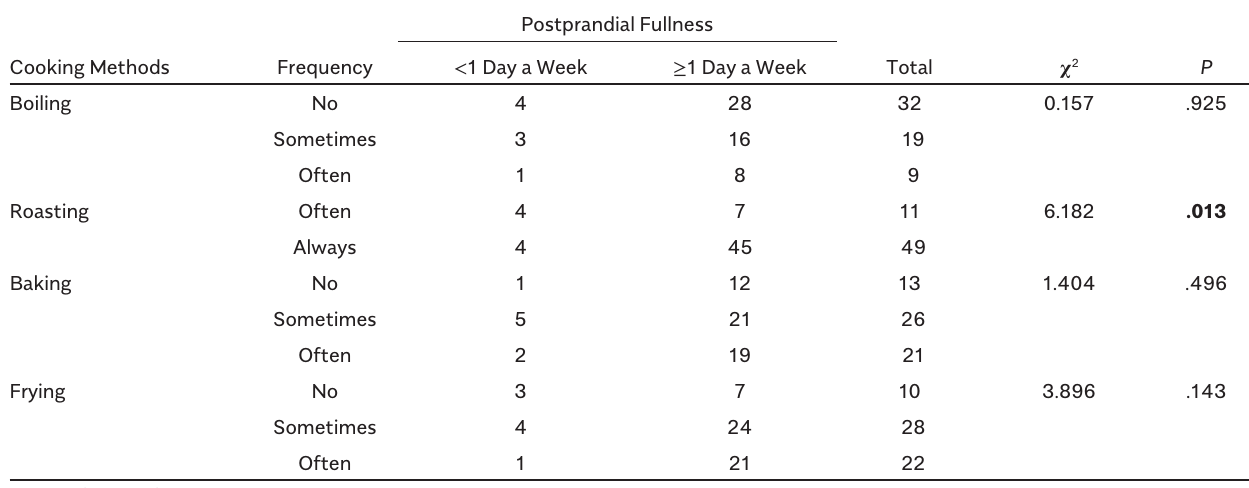
Table 4. Comparison of Cooking Methods According to the Symptom of Postprandial Fullness in the Stomach